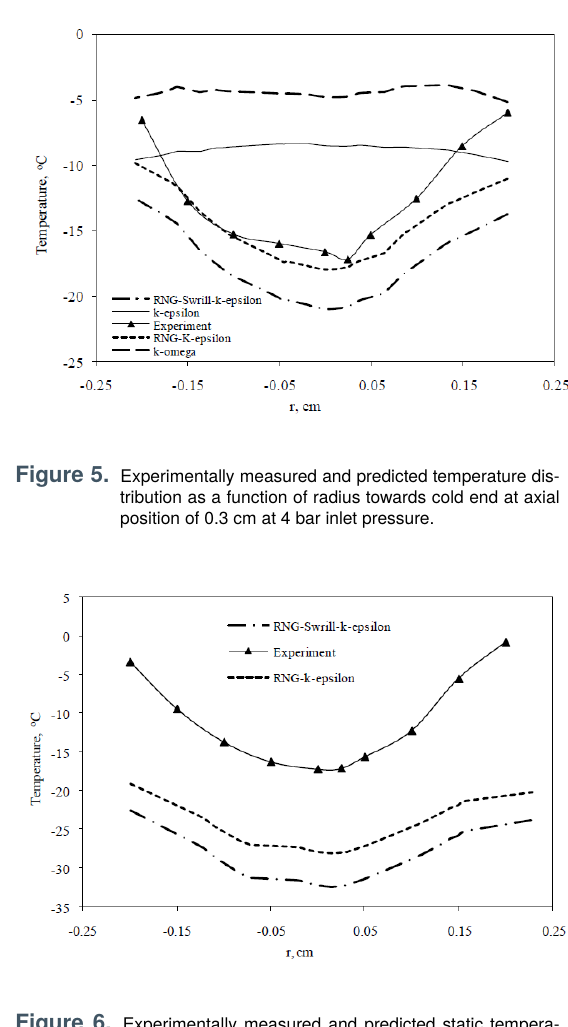
Figure 6. Experimentally measured and predicted static tempera- ture distribution as a function of radius towards cold end at axial position of 0.15 cm at 4 bar inlet